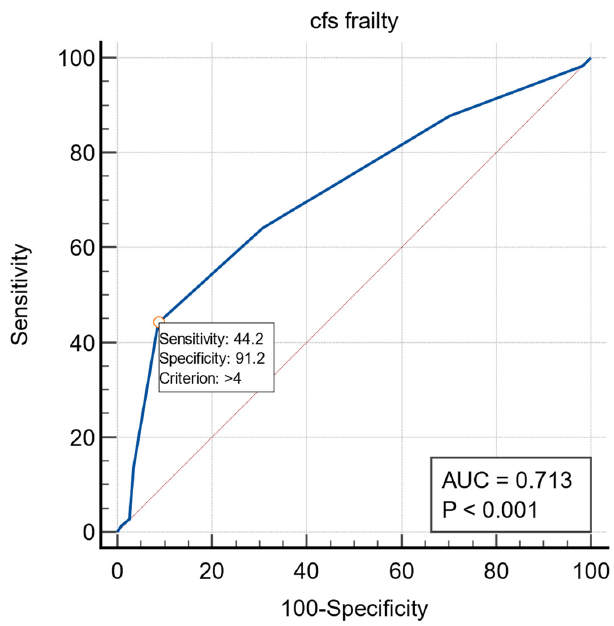
Figure 3. The ROC curves for frailty and dislodgement.